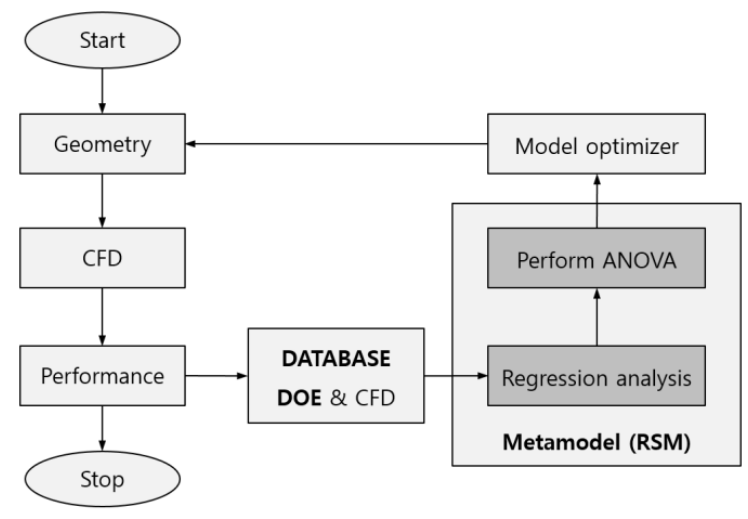
Figure 8. Flowchart of response surface meta-model-based optimization methodology.